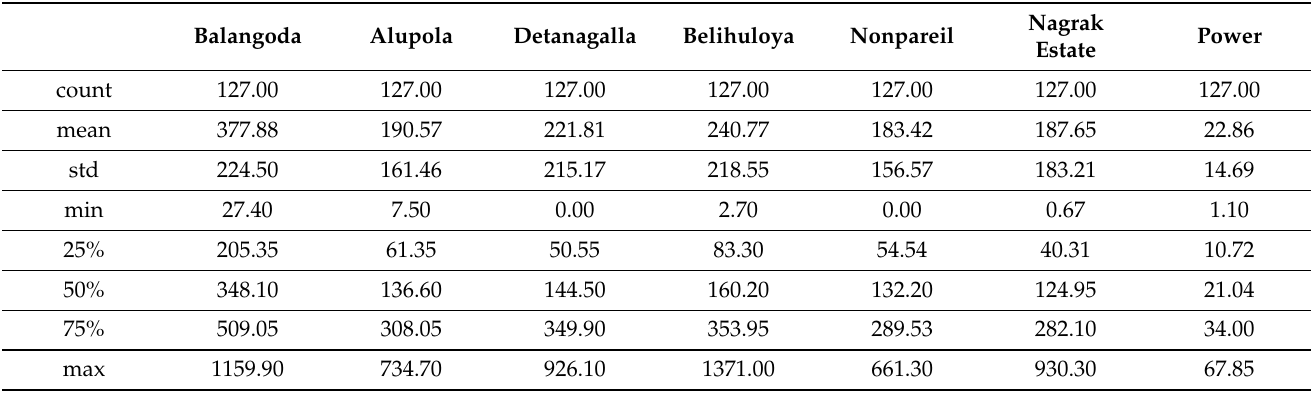
Table 1. Descriptive statistics of the